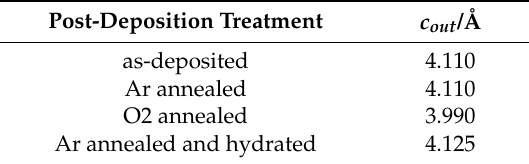
Table 2. Out-of-plane lattice parameter after different post-deposition treatments (±0.001 Å).